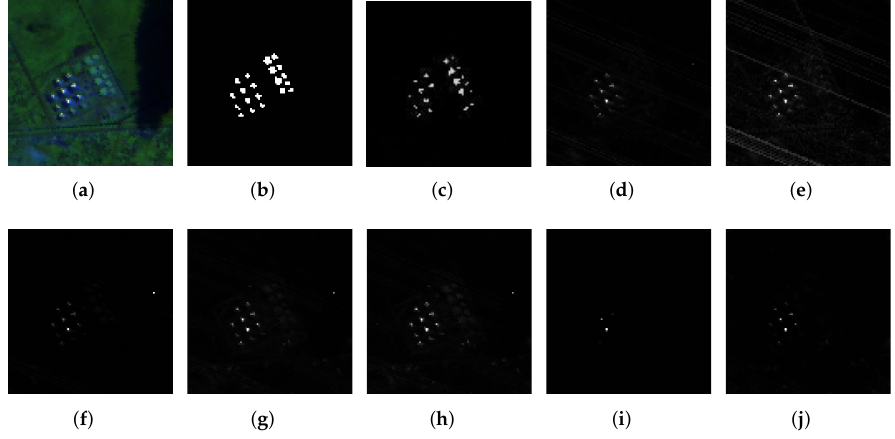
Figure 9. Visual detection results of all the algorithms on the TC-II dataset. ( a ) Pseudocolor